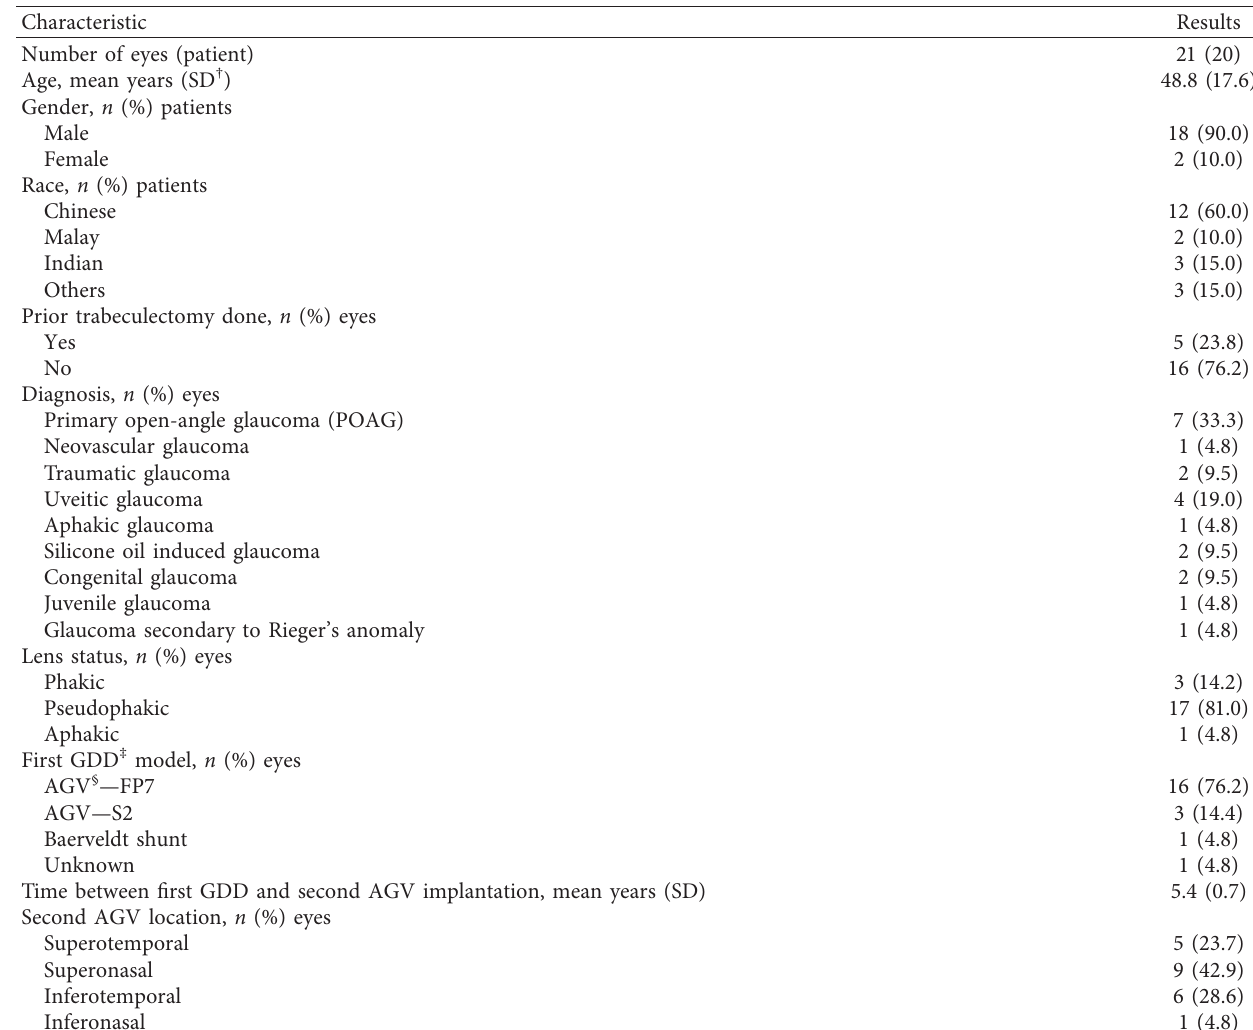
Table 1: Demographic characteristics of patients and eyes in the study sample at the time of the second Ahmed glaucoma valve